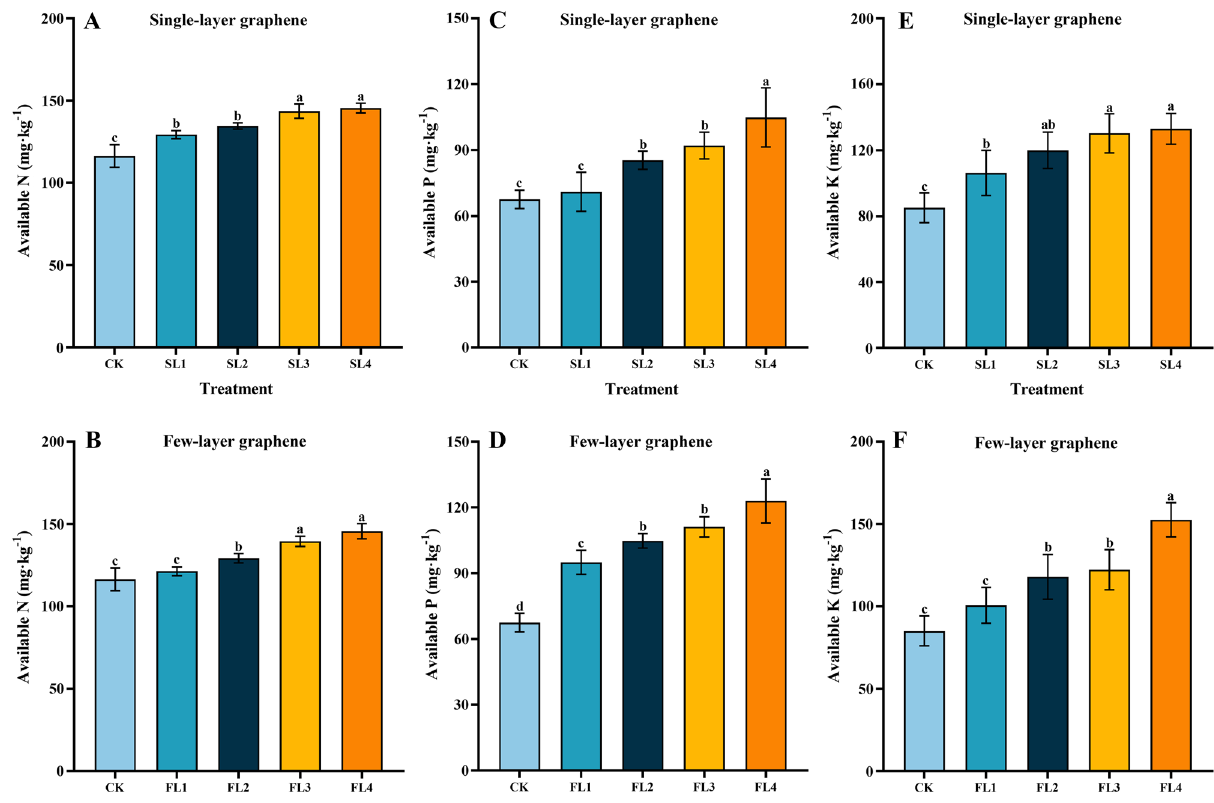
Figure 2. Effect of different graphene concentration and type on soil AN, AP, AK content. CK. 0 g kg −1 single- layer graphene and 0 g kg −1 few-layer graphene; SL1 and FL1. 25 g kg −1 single-layer graphene and 25 g kg −1 few-layer graphene; SL2 and FL2. 50 g kg −1 single-layer graphene and 50 g kg −1 few-layer graphene; SL3 and FL3. 100 g kg −1 single-layer graphene and 100 g kg −1 few-layer graphene; SL4 and FL4. 150 g kg −1 single-layer graphene and 150 g kg −1 few-layer graphene; ( A , C , E ) single-layer treatment; ( B , D , F ) few-layer treatment; error bars indicate ± standard deviation. Different letters above error bars indicate significant difference between treatment ( p < 0.05, LSD